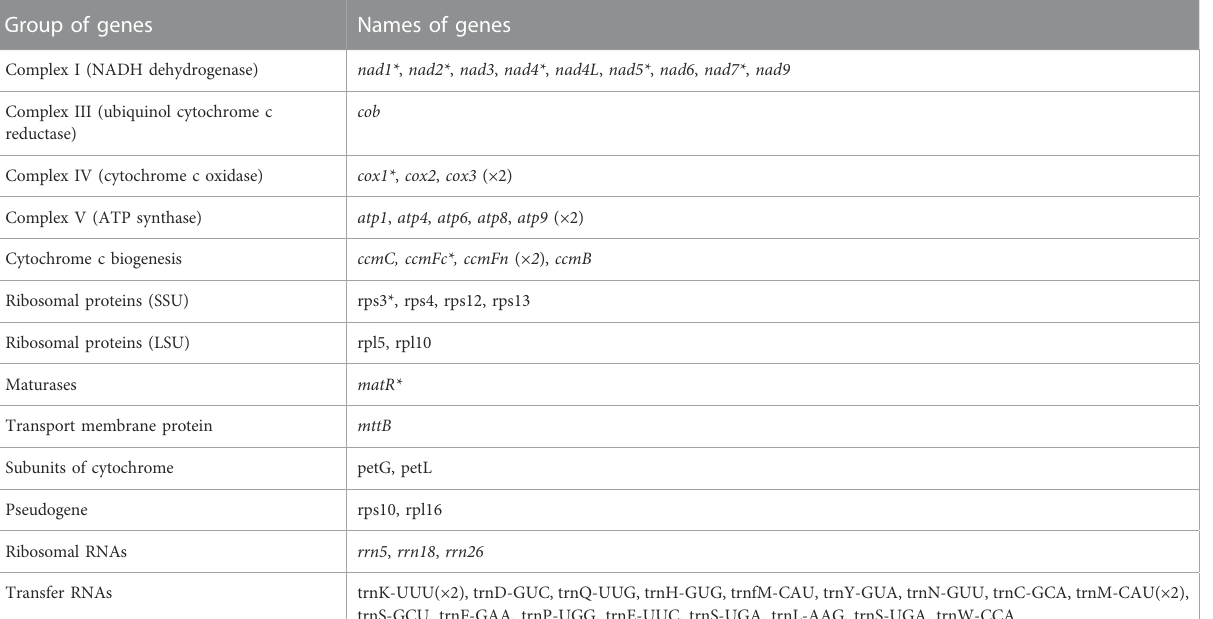
TABLE 2 Gene content of MCB mt